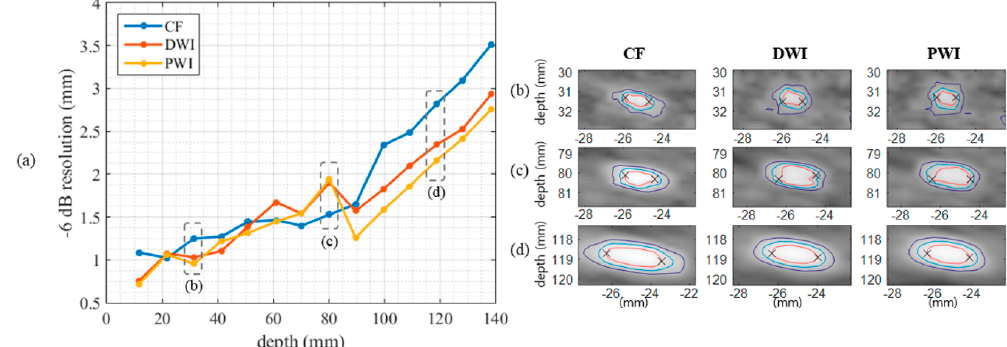
Figure 3. ( a ) Resolution (mm) over depths measured from point targets in the phantom images of CF, DWI, and PWI. DWI and PWI provided a better resolution at depths ≥ 100 mm. ( b – d ) Magnified point target images of Figure 2 at depths of ( b ) 30 mm, ( c ) 80 mm, and ( d ) 120 mm. Red, blue, and purple lines show –6 dB, –12 dB, and –20 dB contours, respectively, and the two crosses in each panel indicate where the maximum lateral distance is measured as the resolution value.